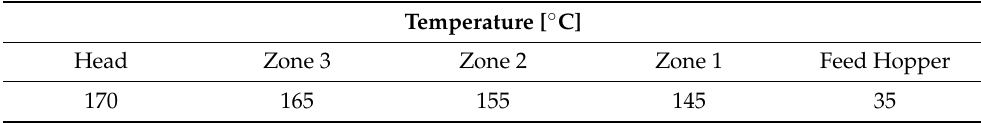
Table 3. Temperature set of a single-screw extruder for the PHBV-hemp fiber biocomposite.